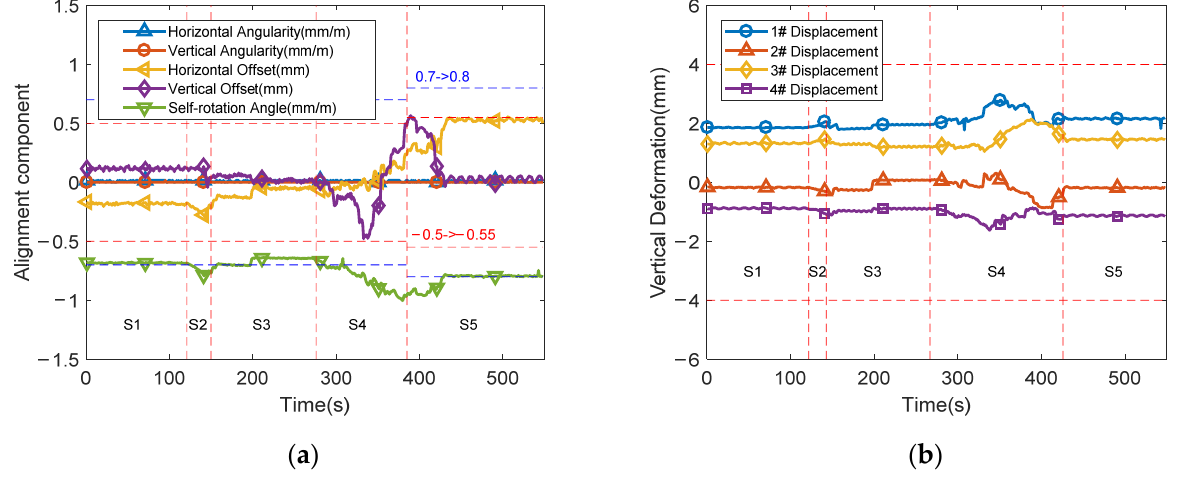
Figure 6. The alignment control process using the alignment autonomous control method: ( a ) The change of the alignment component; ( b ) The change of the deformation of the vertical displacement